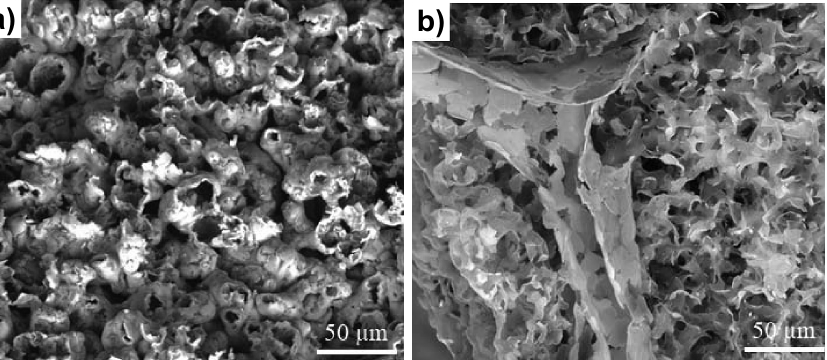
Figure 3. SEM images of the graphite foam samples growth on ( a ) nickel powder, ( b ) nickel powder-nickel foam hybrid. Reprinted with permission from ref. [22] with permission from Elsevier.